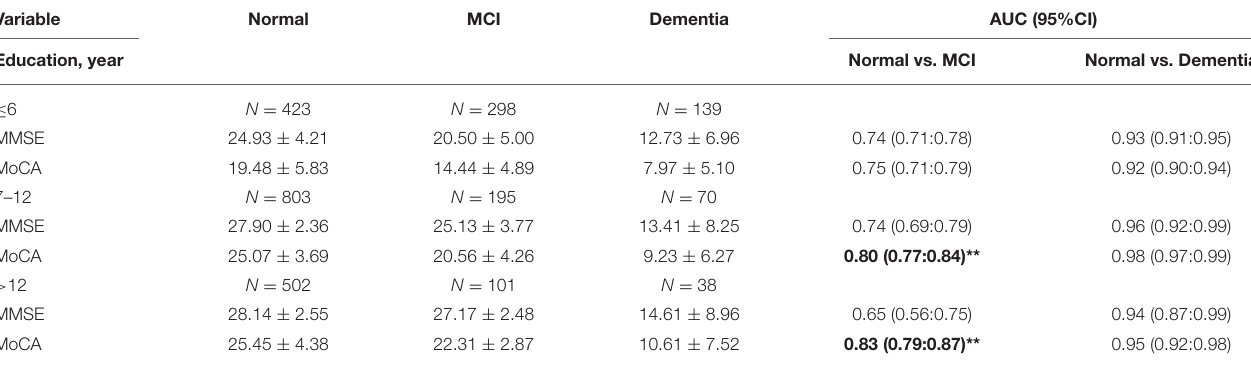
TABLE 4 | MMSE and MoCA data for the normal, MCI and dementia groups by education band. Variable Normal MCI Dementia AUC (95%CI)